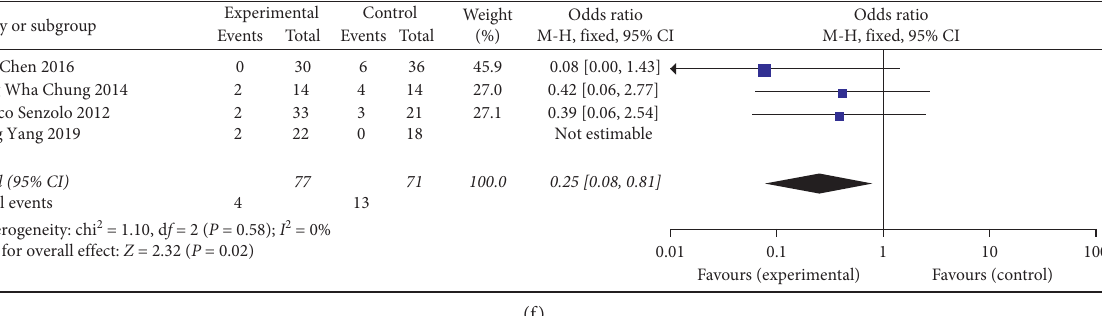
Figure 3: Effect and safety of anticoagulant therapy: (a) analysis of recanalization rate; (b) subgroup analysis of recanalization rate; (c) analysis of thrombus progression or rate of new thrombus formation; (d) bleeding events; (e) other adverse events; (f) mortality rate.